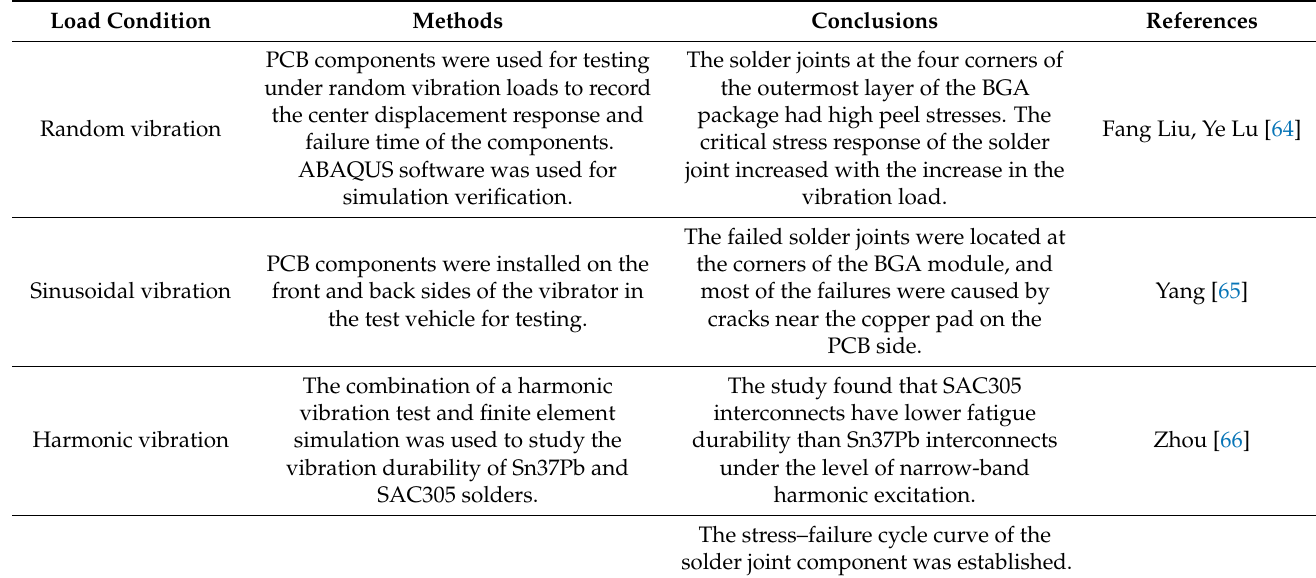
Table 3. Summary of the failure studies under vibration